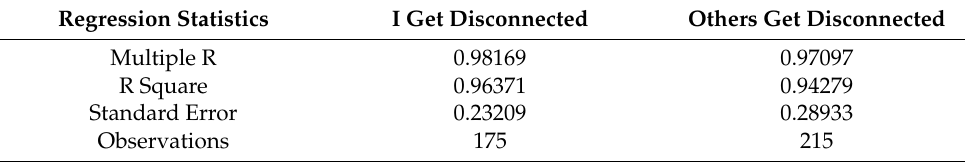
Table 11. The summary output for the disconnection group of